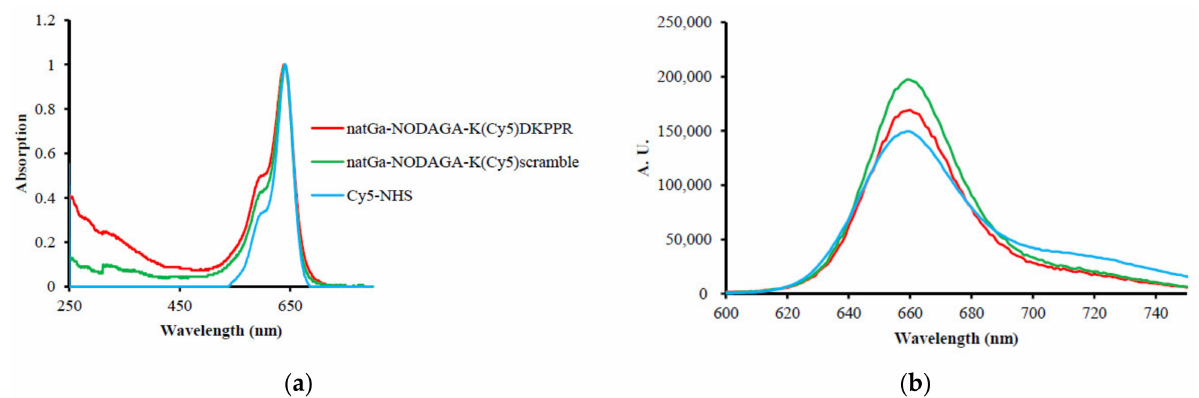
Figure 3. ( a ) Normalized absorption spectra in water. ( b ) Normalized fluorescence emission spectra in water ( λ ex = 590 nm). Table 1. Molar extinction coefficient ( ε ) and fluorescence quantum yield ( ϕ F ) of nat Ga-NODAGA-